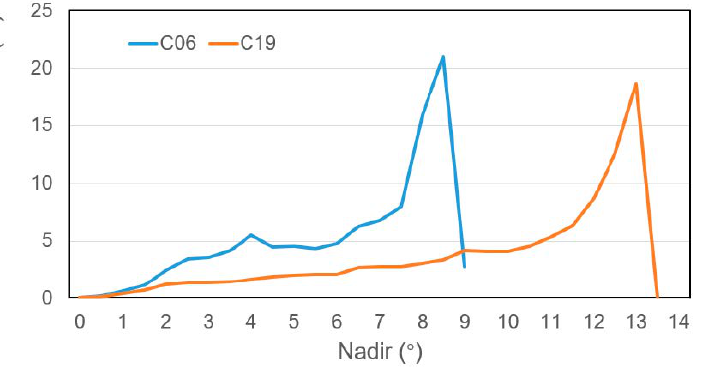
Figure 4. Distribution of observations with respect to the satellite nadir angle for representative IGSO C06 and MEO C19 satellites. C06 and MEO C19